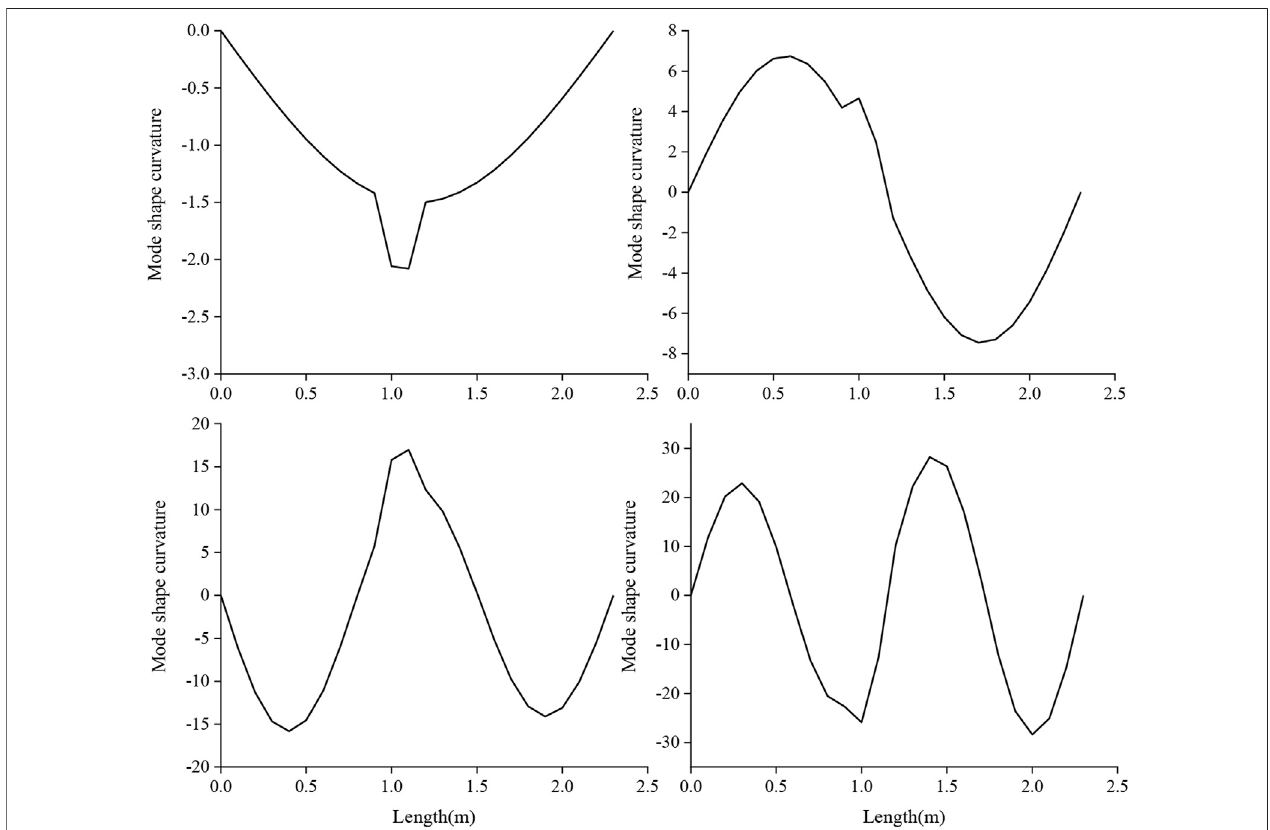
FIGURE 15 | First four mode shape curvatures of BG1 of damaged